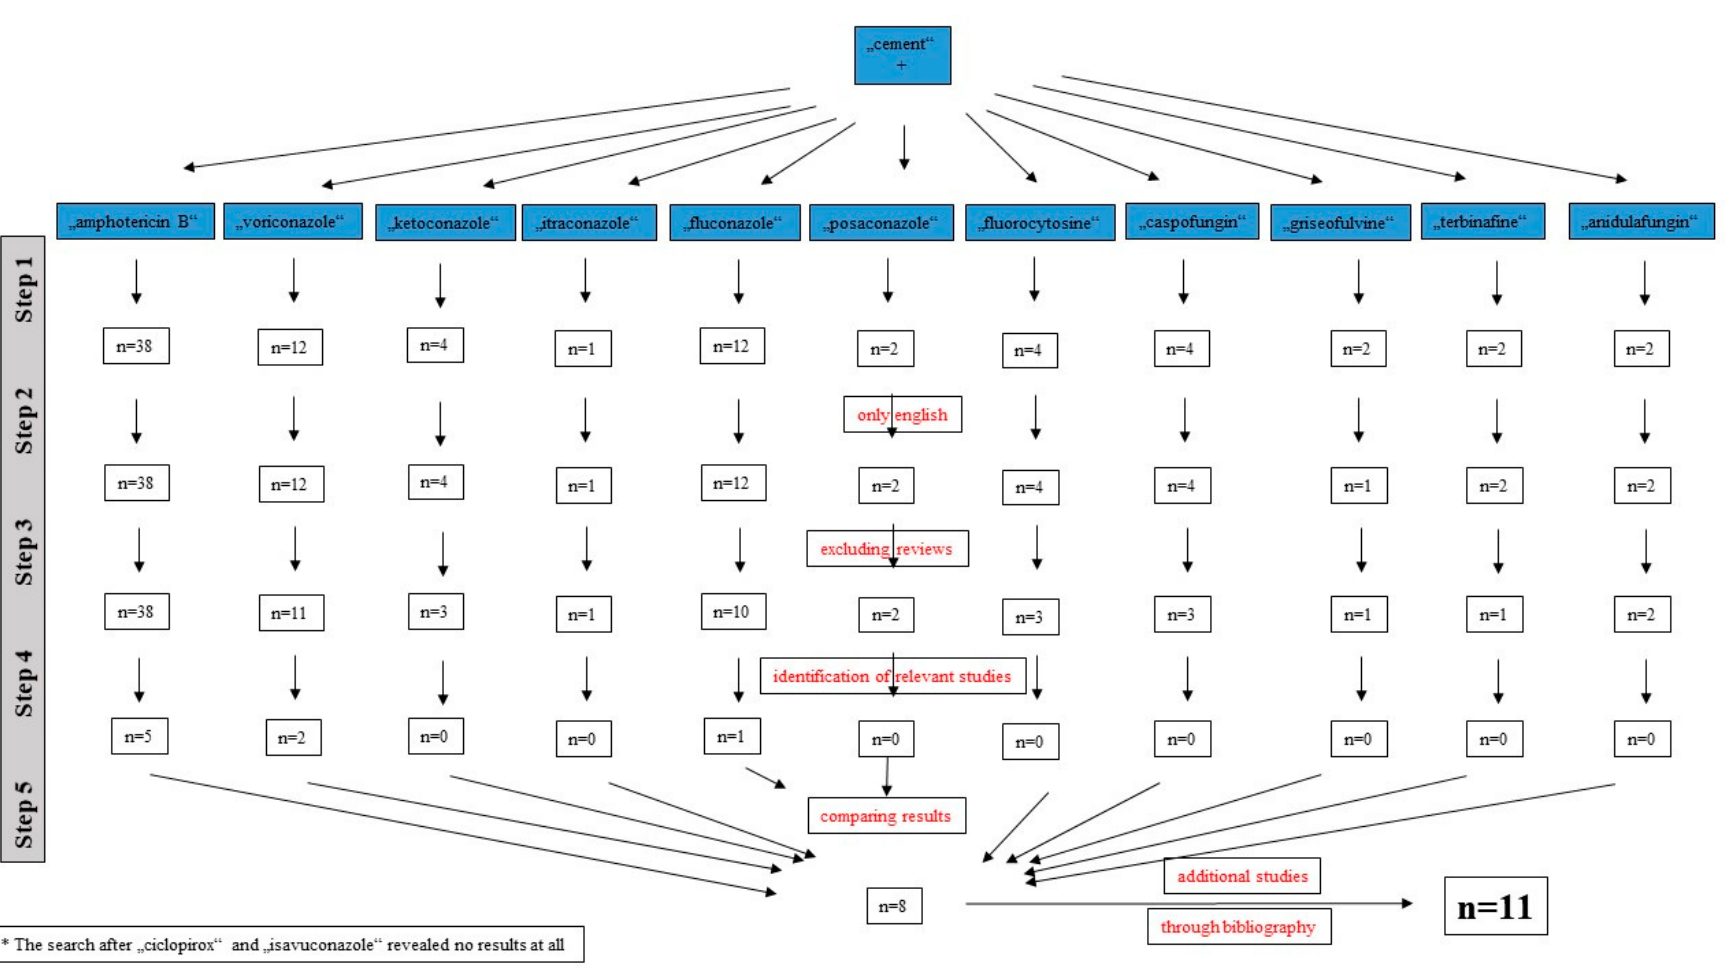
Figure 2. Literature search for identification of studies about the use of antifungal-loaded acrylic bone cement in the treatment of periprosthetic hip and knee joint infections.